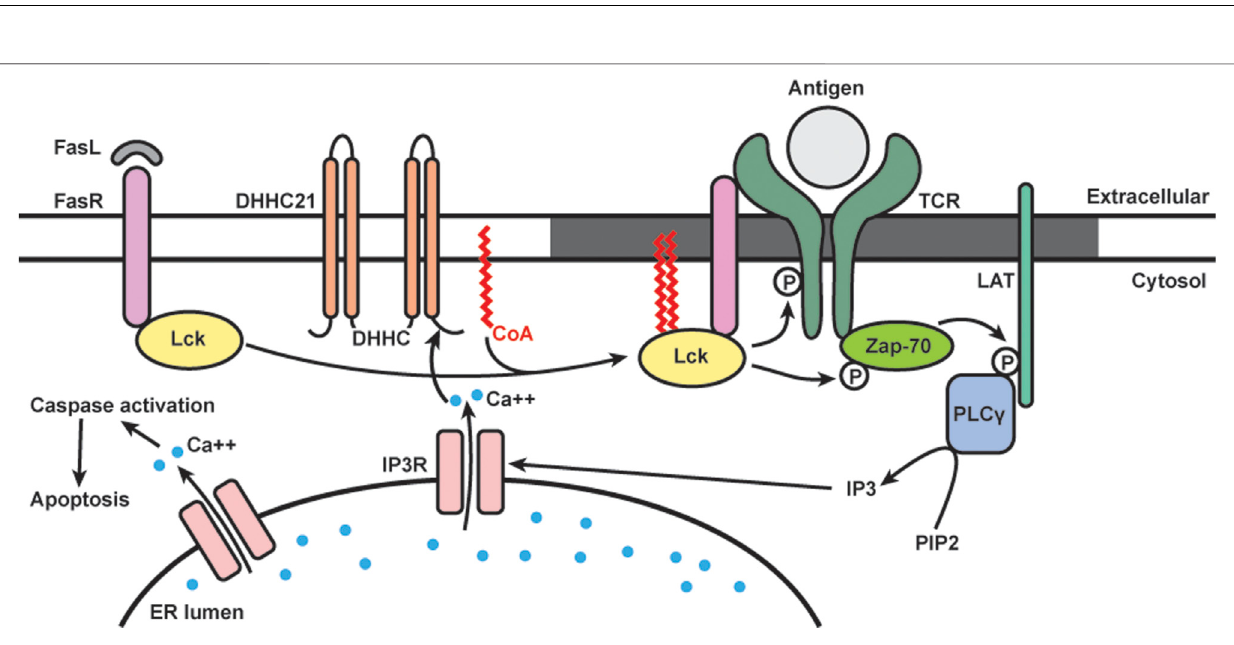
Frontiers in Molecular Biosciences |